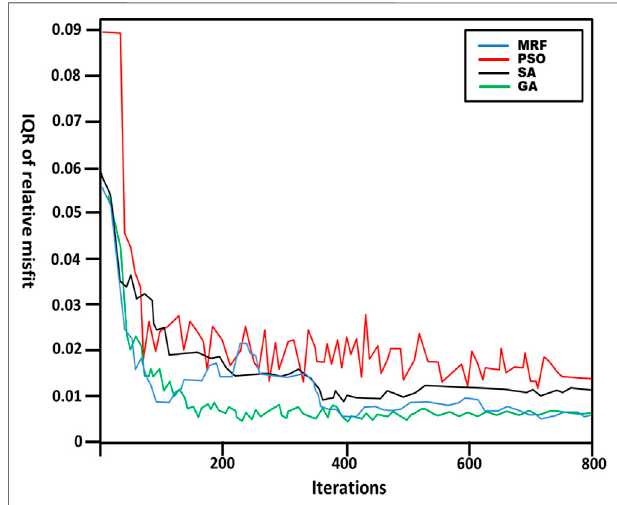
FIGURE 8 | Comparative convergence for the MRF, PSO, GA and SA methods.